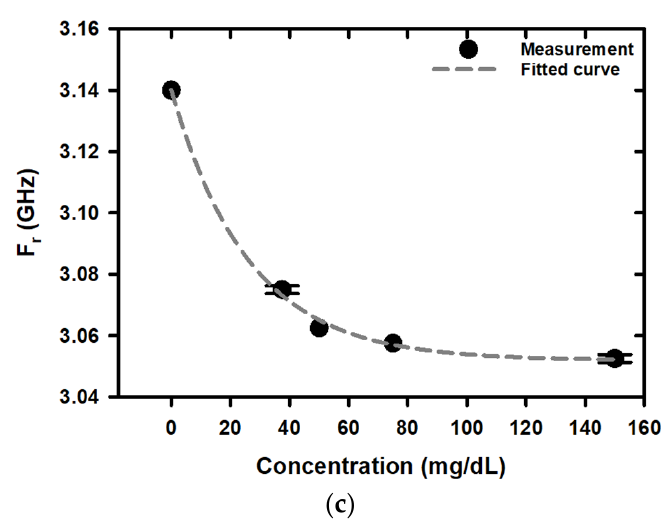
Figure 7. Sensor response signal in peak 2. ( a ) Smooth data and effect of glucose concentration on ( b ) S 11 and ( c ) resonant frequency on of the microwave sensor, as measured by the reflection coefficient for glucose concentrations of 0, 37.5, 50, 75, and 150 mg/dL in the solution.